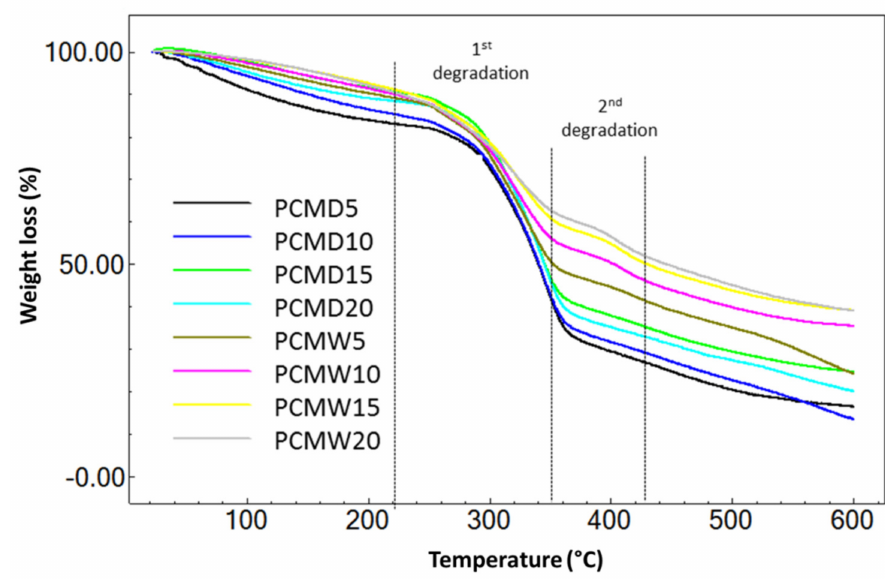
Figure 6. Weight loss of PCM, influenced by the impregnation conditions. Two exothermic peaks were seen in the DSC curves for both PCMD and PCMW, as shown in Figure 7. The first exothermic peak at 30–110 ◦ C was due to the release of water. The second peak appeared at 240–248 ◦ C, which corresponded to the T g value of the PCM. The results support that the PF had good compatibility with the CM—there was a single T g in every sample [42], usually at around 240–248 ◦ C, except for PCMW10. The T g for PCMW10 was found to be at 220 ◦ C, likely due to the formation of defects, voids, or aggregation, during the curing process [41]. The T g values of PCMD and PCMW decreased as the concentration of PF resin increased. The PF resin hindered homogeneous heat flow during the DSC analysis, hence lowering the T g value [42].